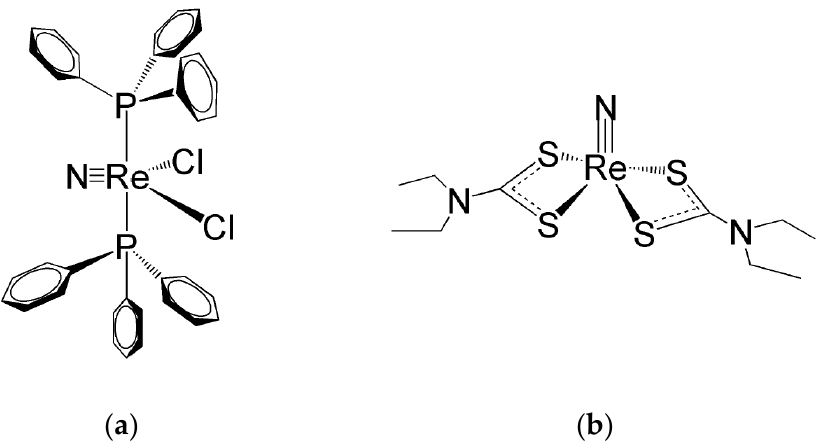
Figure 8. ( a ) The mixed halogeno-phosphino Re(V) complex (Re(N)Cl 2 (PPh 3 ) 2 ) [33] and ( b ) the bis-substituted complex (Re(N)(CS 2 NEt 2 ) 2 ) [51].